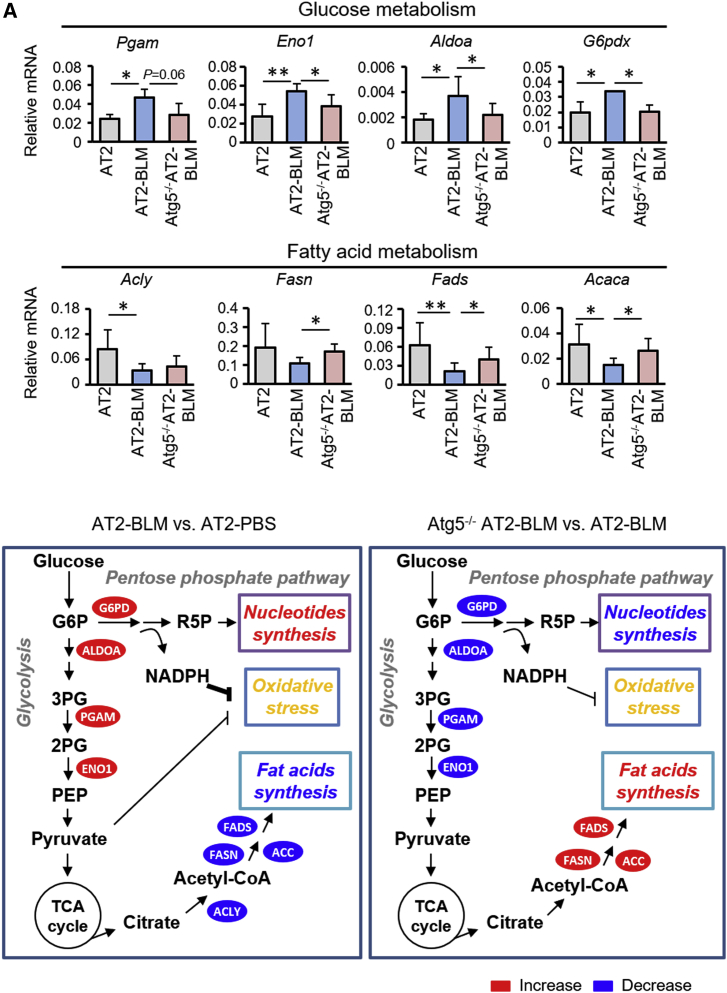
Autophagy Reprograms Metabolic Pathways in AT2 Cells in Response to BLM Challenge(A) qPCR validation of transcripts associated with glucose metabolism and fatty acid metabolism in AT2 cells (n = 3). Data are representative of three independent experiments with error bars representing the mean ± SD. ∗p < 0.05, ∗∗p < 0.01.(B) Schematic showing alterations in intermediates associated with glycolysis, pentose phosphate pathway, and synthesis of fatty acids in AT2 cells. Intermediates with increased and decreased expression are labeled in red and blue, respectively. G6P, glucose 6-phosphate; 3PG, 3-phosphoglyceric acid; 2PG, 2-phosphoglyceric acid; and PEP, phosphoenolpyruvate.